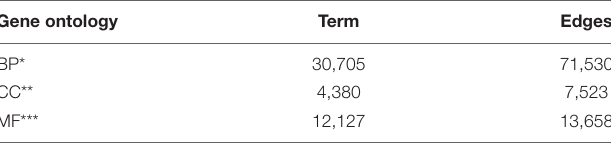
TABLE 1 | Characteristics of GO